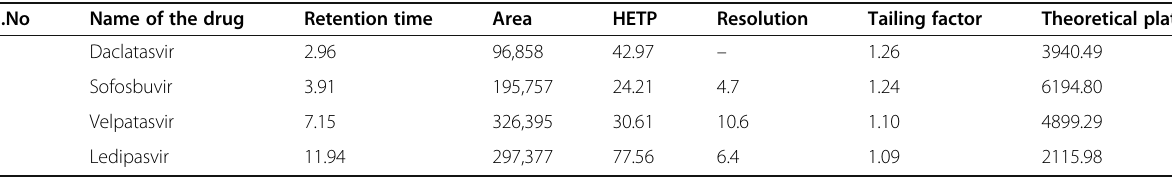
Table 6 Chromatographic results for the optimized method